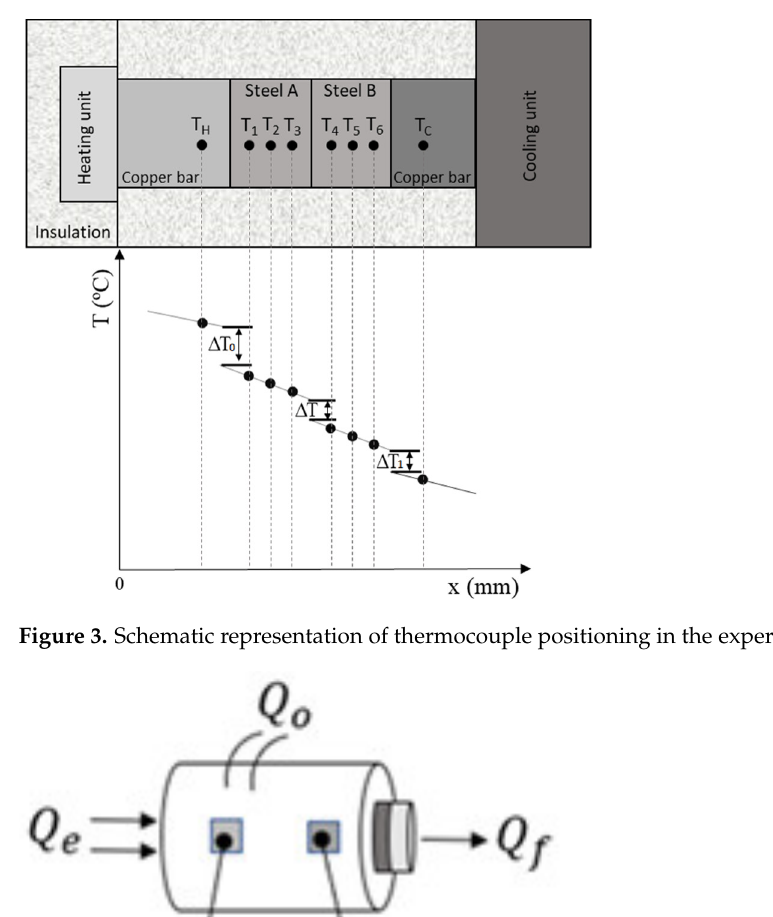
Figure 4. Representation of heat flow through the system.